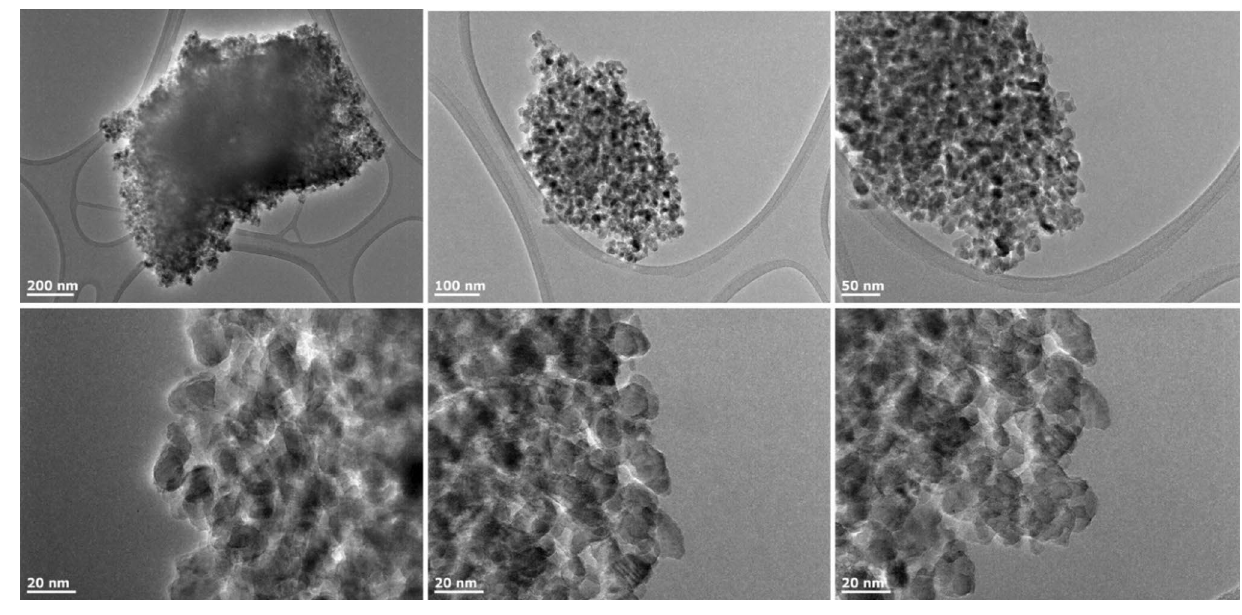
Fig. 2 TEM images of CdZnTiO